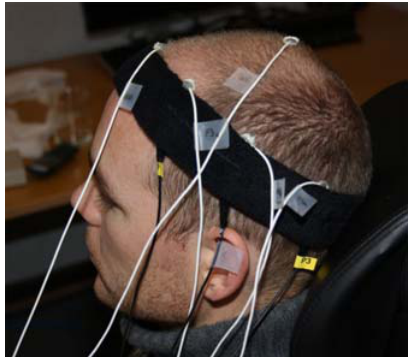
Figure 3. Experimental setup. The white leads are connected to standard electrodes; the black ones are connected to textile